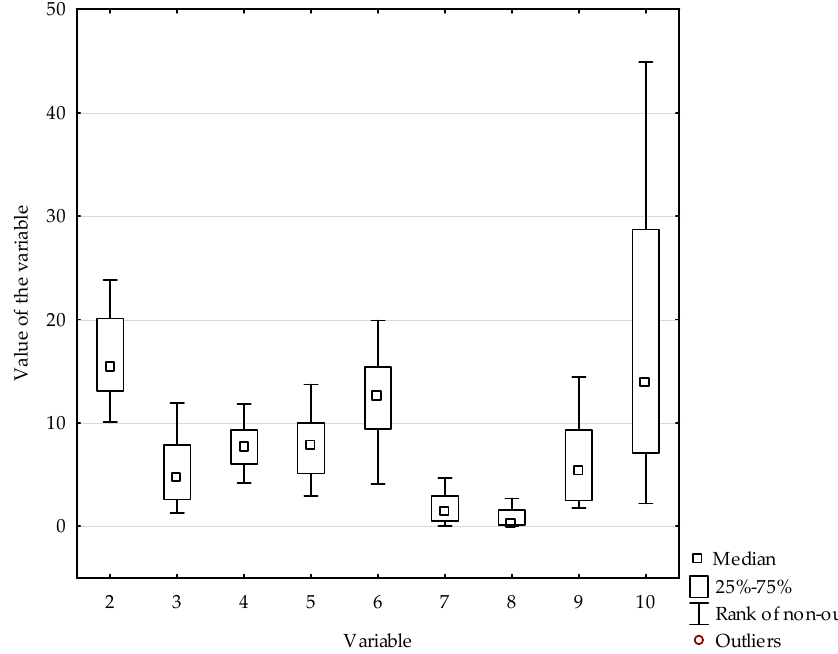
Figure 1. Distributions of variables with winsorized data.